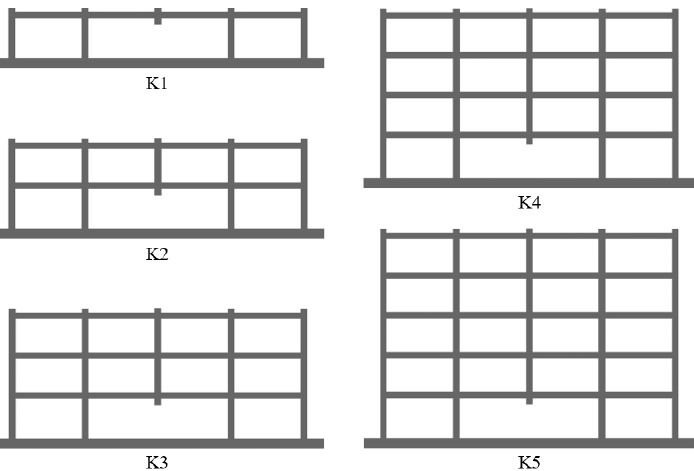
Figure 16. Multi-storey reinforced concrete frames under progressive collapse scenarios.